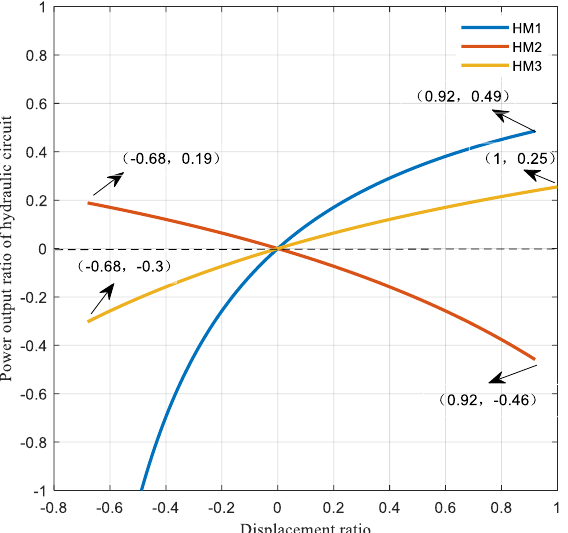
Figure 10. Relationship between power output ratio and displacement ratio e of the hydraulic cir- cuit.